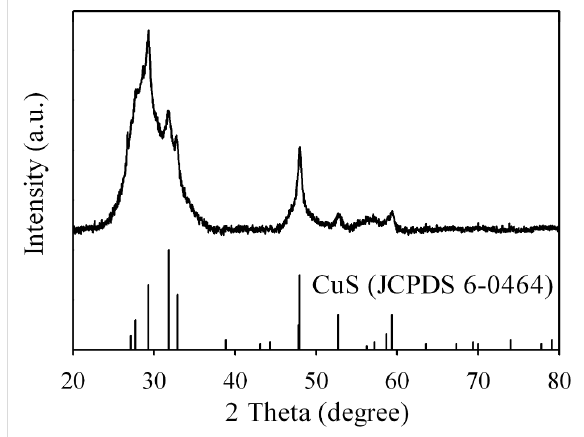
Figure 7: XRD pattern of the precipitate collected from the precursor solution without TGA prior to hydrothermal reaction.